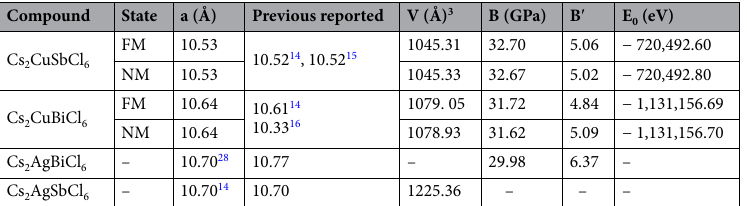
Table 1. The optimized lattice parameters of cubic Cs 2 CuMCl 6 (M = Sb, Bi) with space group Fm 3 m in both spin-polarized and non-polarized states.